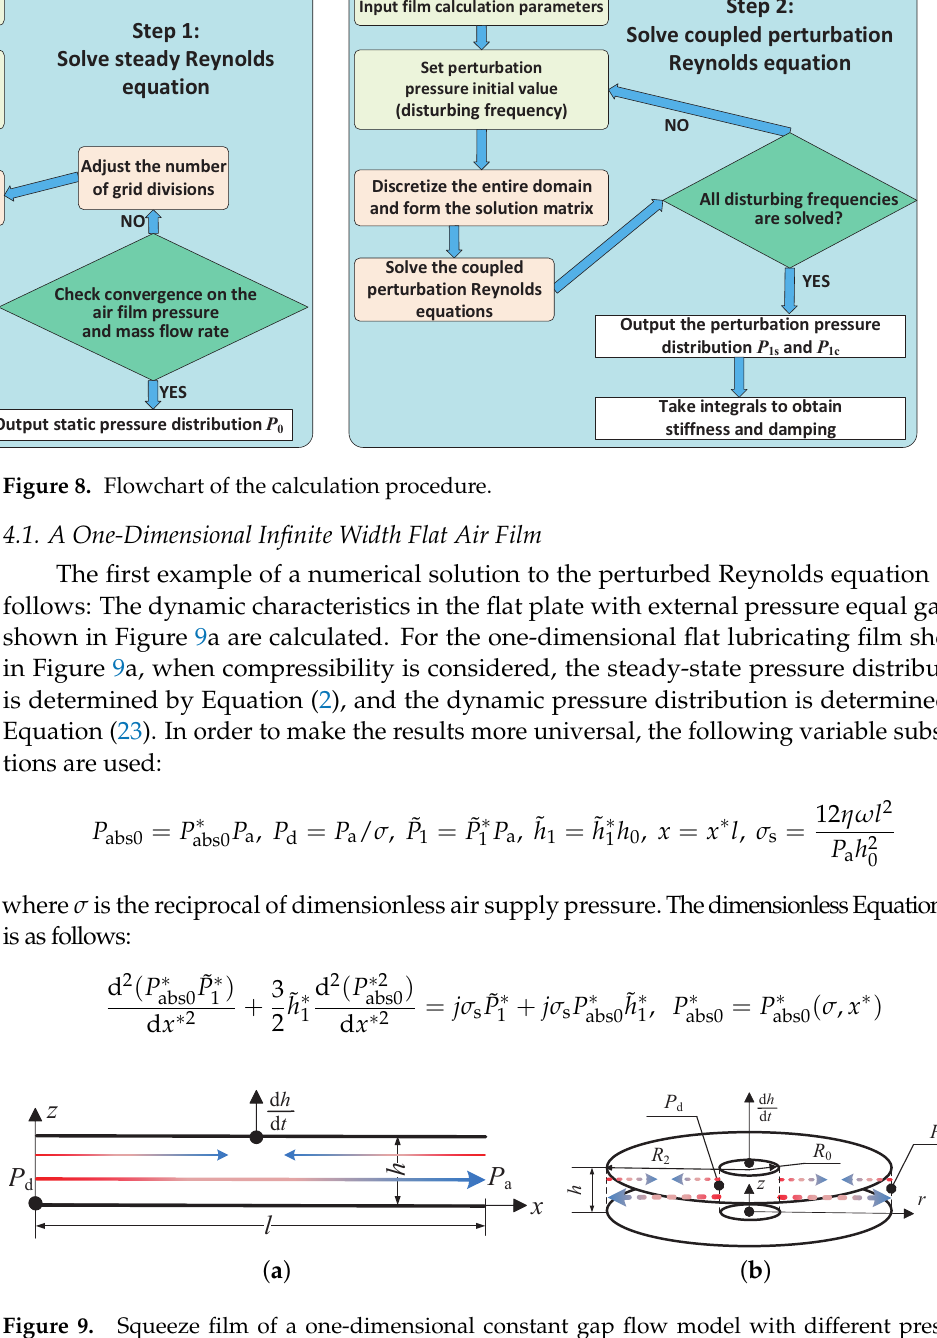
Figure 9. Squeeze film of a one-dimensional constant gap flow model with different pressure boundaries: ( a ) infinite width flat air film; and ( b ) circular air